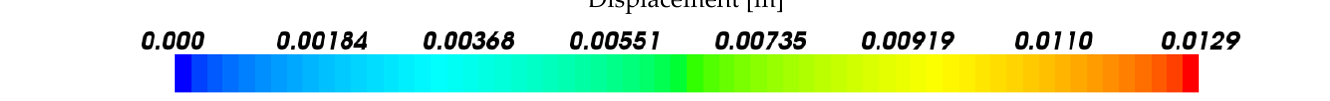
Figure 11. Displacements contour plots calculated with the finite element model with contraction joints.